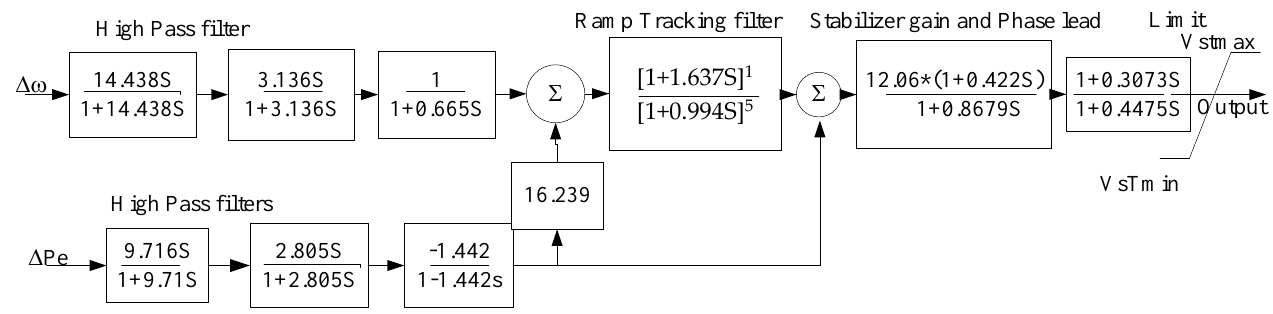
Figure 6. Optimally sized power system stabilizer lead-lag structure.